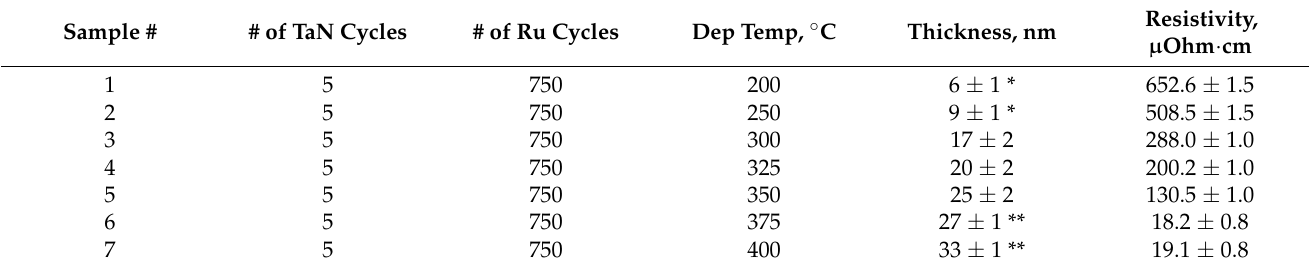
Table 1. Parameters of the